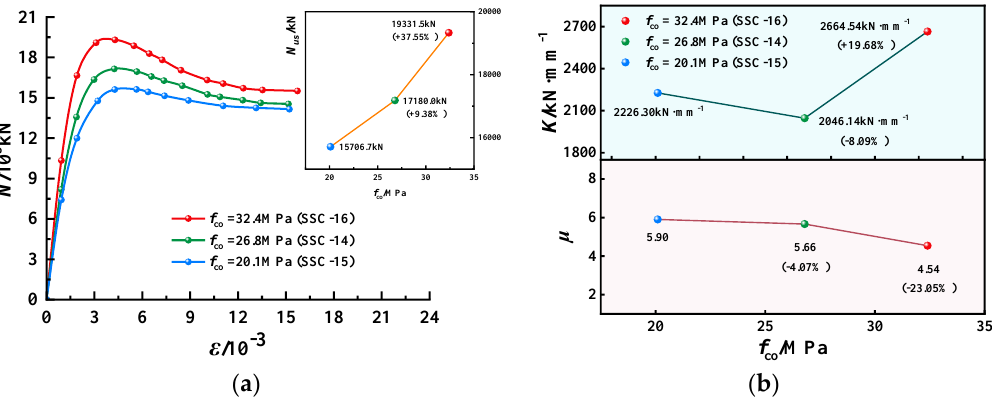
Figure 11. N - ε curves, K and µ of EGCSSCs with different t gfrp : ( a ) N - ε curves of specimens with cross-section height of 800 mm. ( b ) K and µ of specimens with cross-section height of 800 mm.